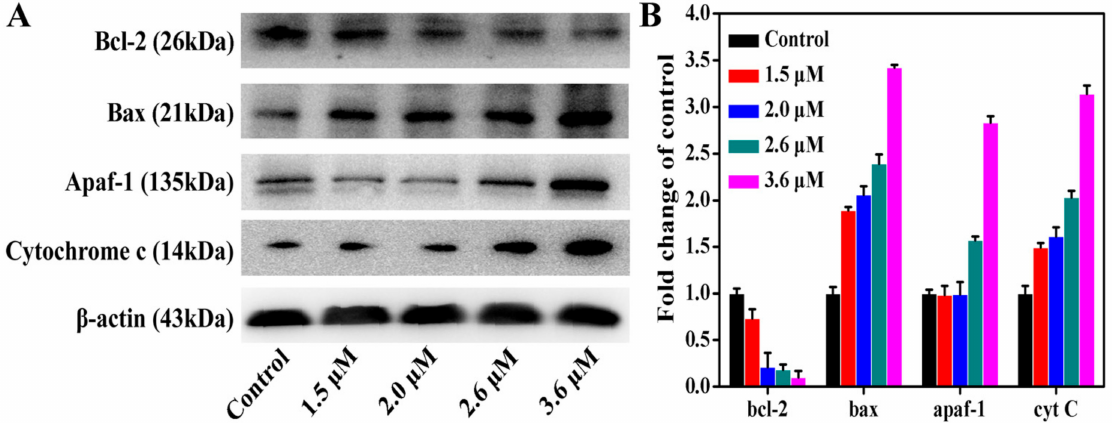
Figure 11. The western blot assay of apoptosis-related protein levels in Hep-G2 cells treated with complex 1 (1.5, 2.0, 2.6, and 3.6 µ M) for 24 h. ( A ) Western blot was used to determine the expression levels of bax, cytochrome c, apaf-1, and bcl-2 in MGC80-3 cells treated with complex 1 (1.5, 2.0, 2.6, and 3.6 µ M) for 24 h; ( B ) Densitometric analysis of apoptotic-related proteins normalized to β -actin. The relative expression of each protein is represented by the density of the protein band/density